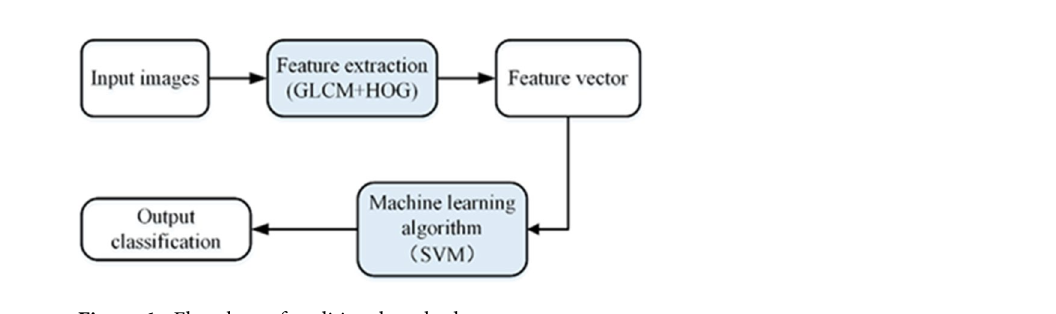
Figure 6. Flowchart of traditional